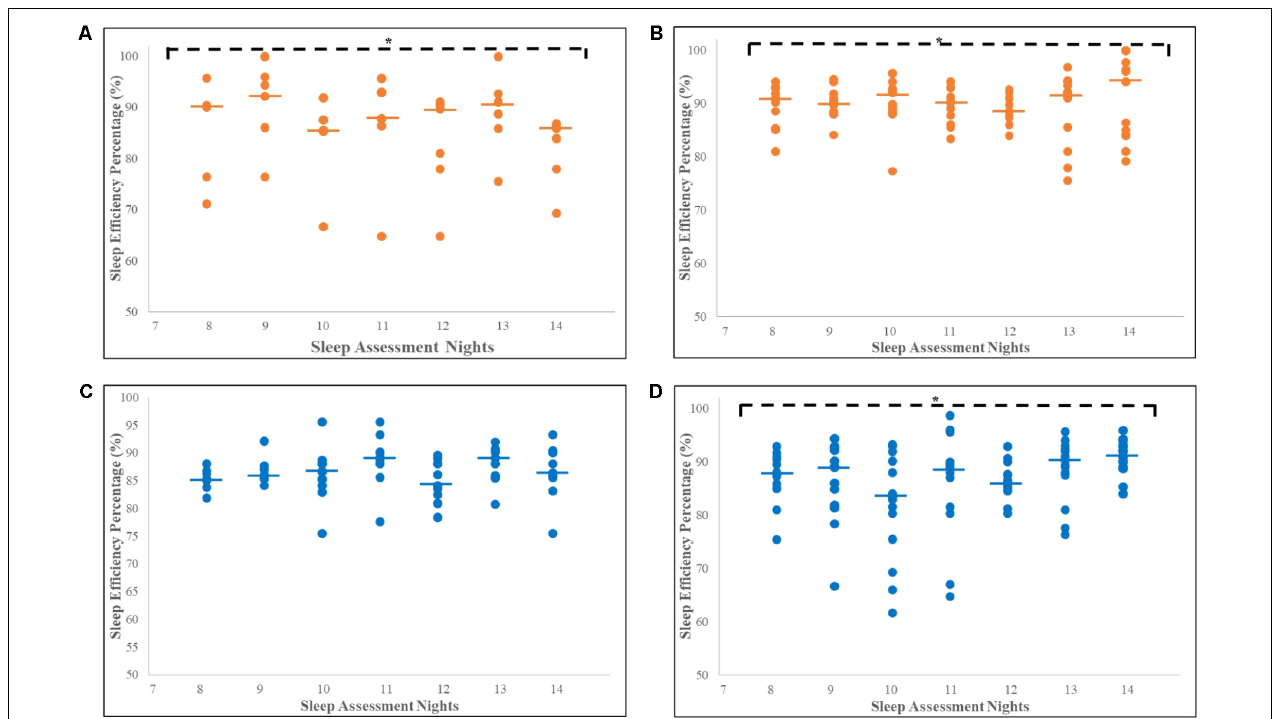
FIGURE 2 | Increase in sleep efficiency percentage for seven consecutive nights for CU and non-CU receiving either haloperidol or risperidone. Each dot represents individual SE% for each subject and the thick horizontal lines indicate the median, on each assessment night. ∗ Significant increase in SE% over 7 days of recording. (A) Significant increase in median SE% for non-CU receiving haloperidol ( n = 6; χ 2 = 16.822, p = 0.010, df = 6). (B) Significant increase in median SE% for non-CU receiving risperidone ( n = 14; χ 2 = 13.84, p = 0.032, df = 6). (C) No significant increase in median SE% for CU receiving haloperidol ( n = 12; χ 2 = 2.78, p = 0.180, df = 6). (D) Significant increase in median SE% for CU receiving risperidone ( n = 18; χ 2 = 12.90, p = 0.045, df = 6). Trend analyses were conducted using Friedman’s tests, with p < 0.05 representing significance. CU, Cannabis User; non-CU, non-user of Cannabis ; SE%, Sleep Efficiency